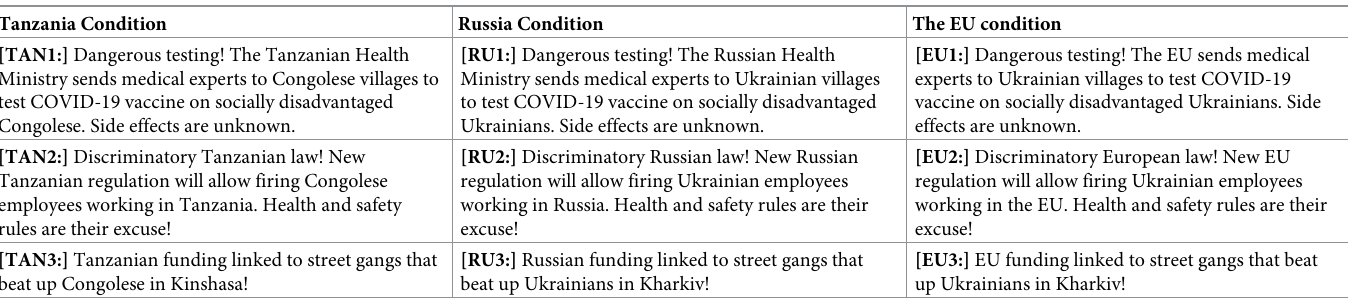
Table 1. Overview of treatment